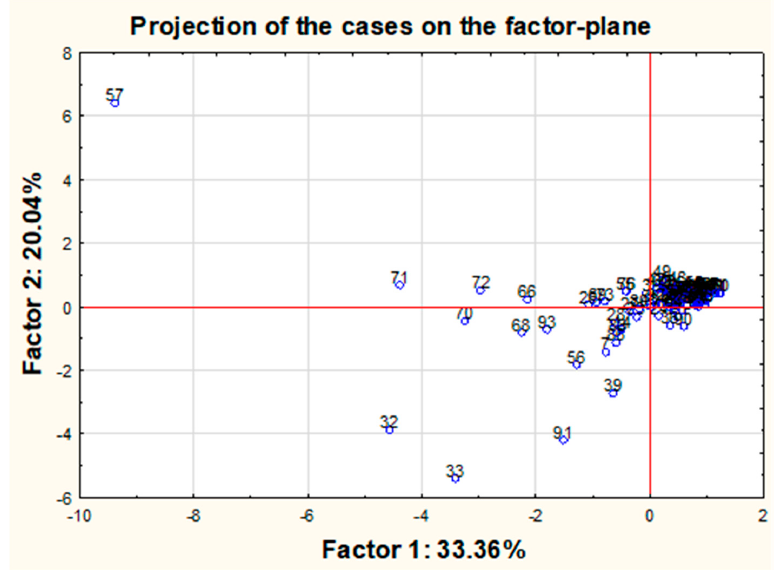
Figure 8. Projection of objects for the first two components for all studied eye shadow samples after the scale